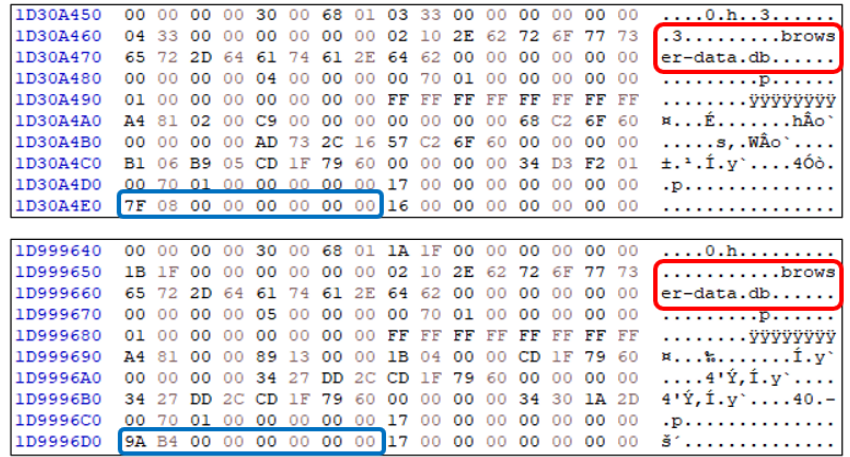
Figure 9. Two different offsets ( blue ) of ‘browser-data.db’ file ( red ).